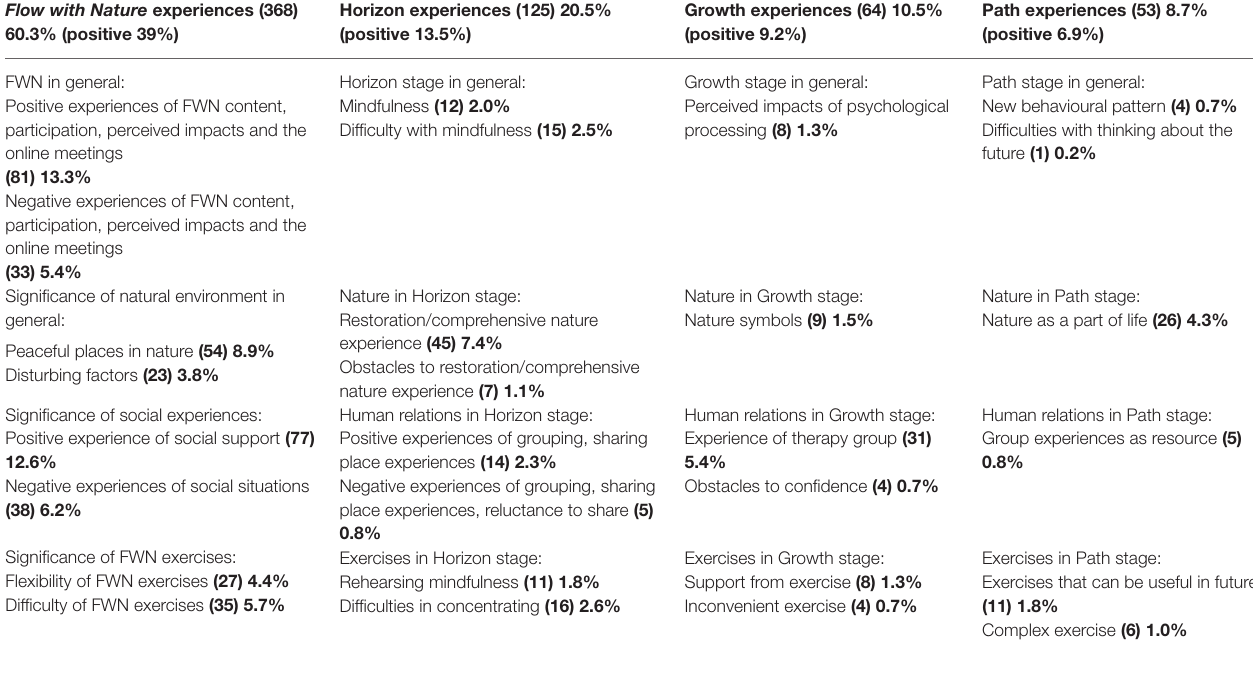
TABLE 3 | Participants’ experiences in the FWN treatment (main categories and subcategories; frequency and percentage of mentions in the main categories). Flow with Nature experiences (368) Horizon experiences (125) 20.5% 60.3% (positive 39%) (positive